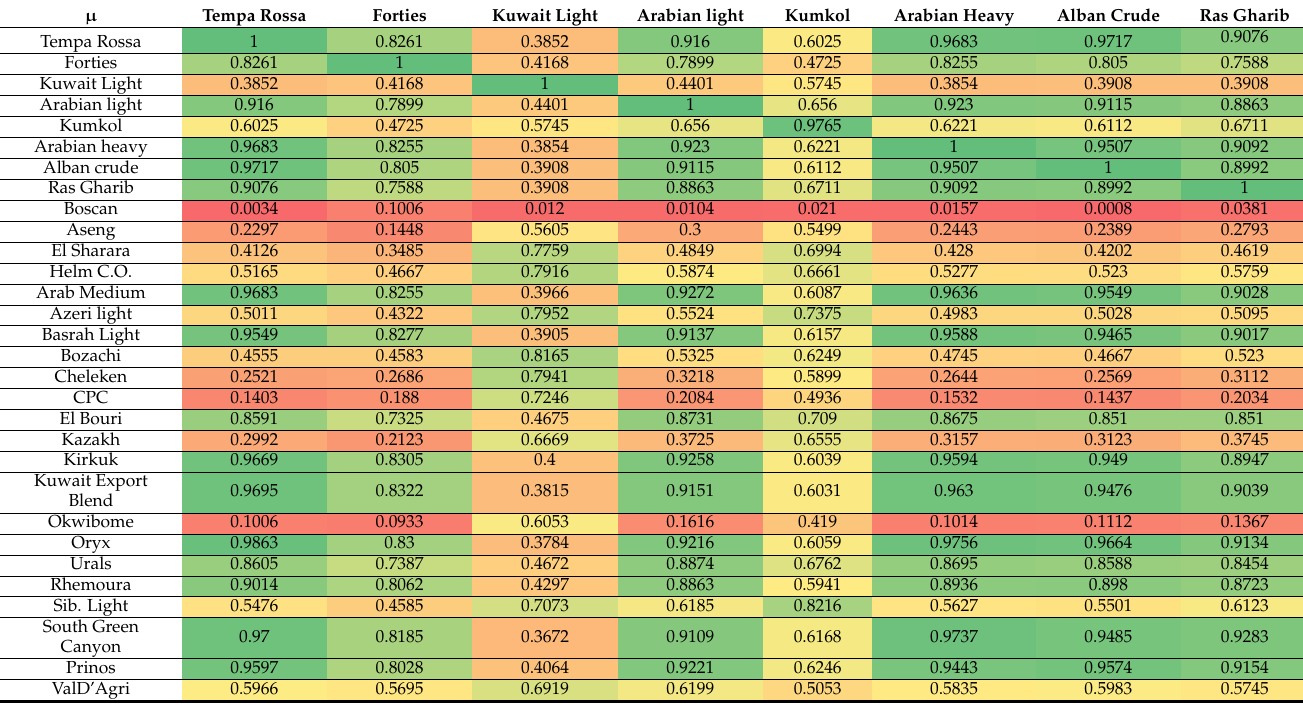
Table 2. Degree of similarity between some of the investigated crude oils determined based on the ap- plication of intercriteria analysis and HTSD data, total sulphur content, and crude oil specific gravity.